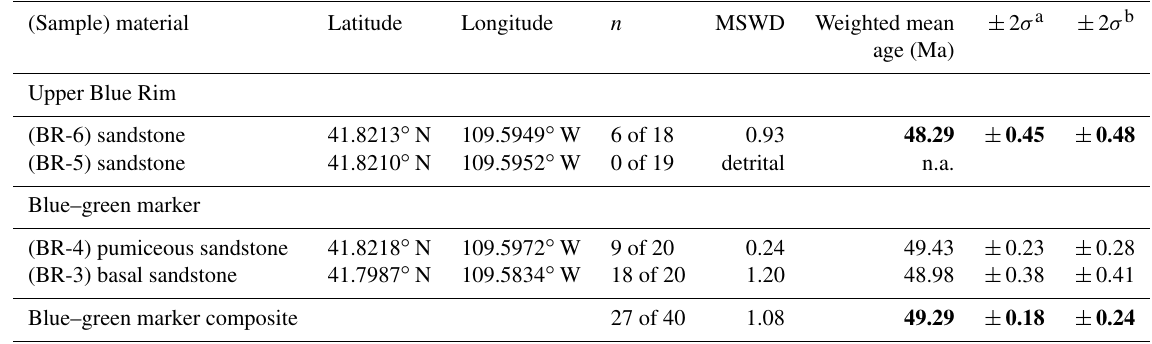
Table 1. Summary of single-crystal sanidine 40 Ar / 39 Ar analyses: Bridger Formation, Blue Rim, WY. (Sample) material Latitude Longitude n MSWD Weighted